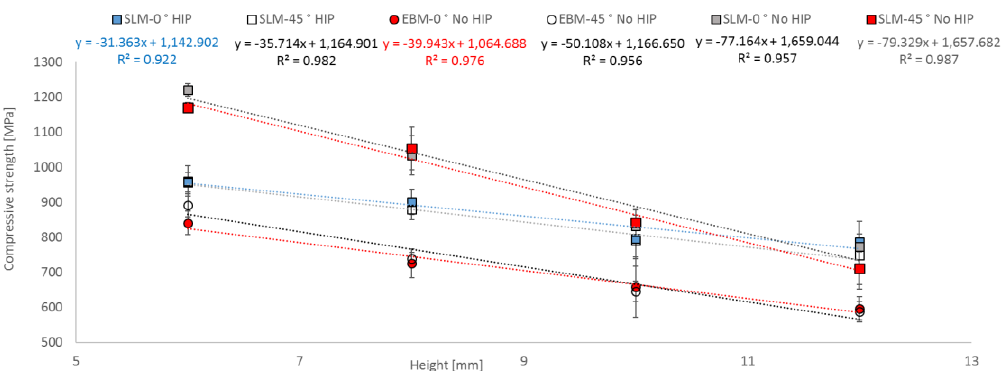
Figure 17. Relation between height and compressive strength for SLM parts (HIP) and EBM parts (No HIP) in 0° and 45 ° orientation in comparison to SLM parts (No HIP) in 0° and 45° orientation A linear relationship was found between equivalent diameter and compression strength.